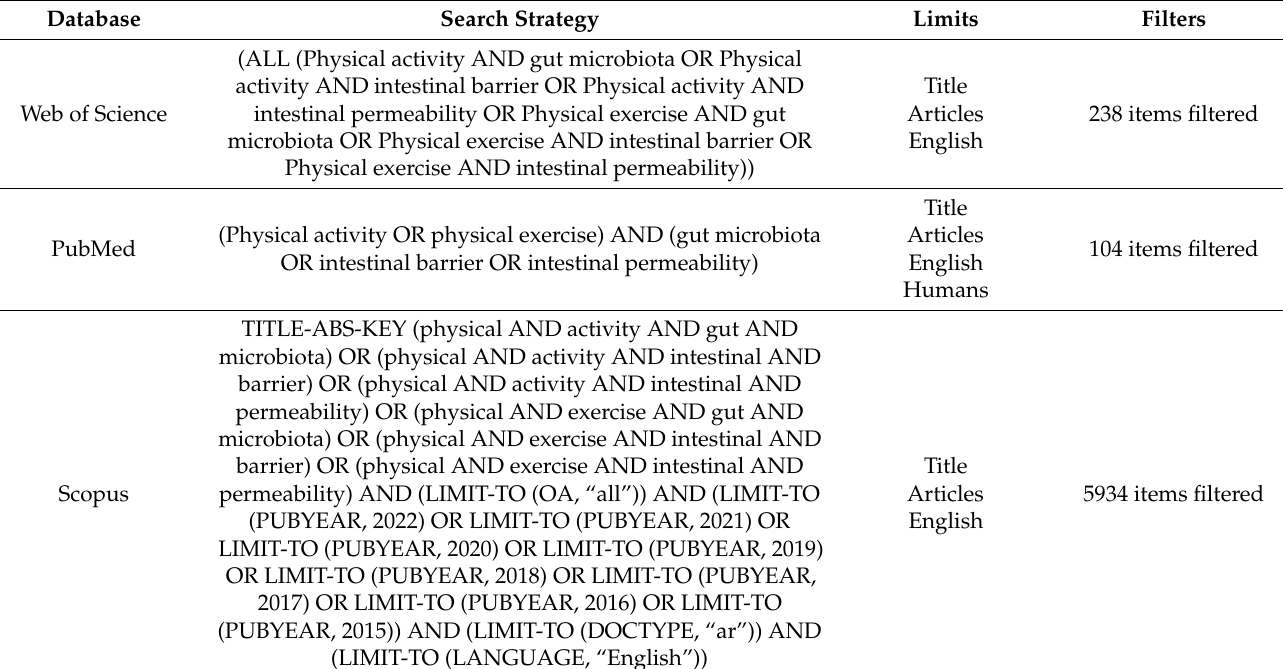
Table 1. Search strategy in